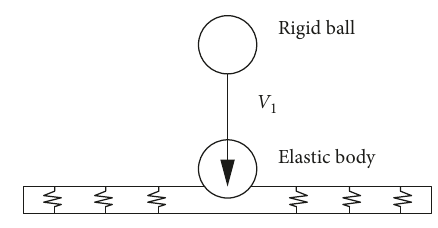
Figure 2: Rigid sphere impacting elastic half